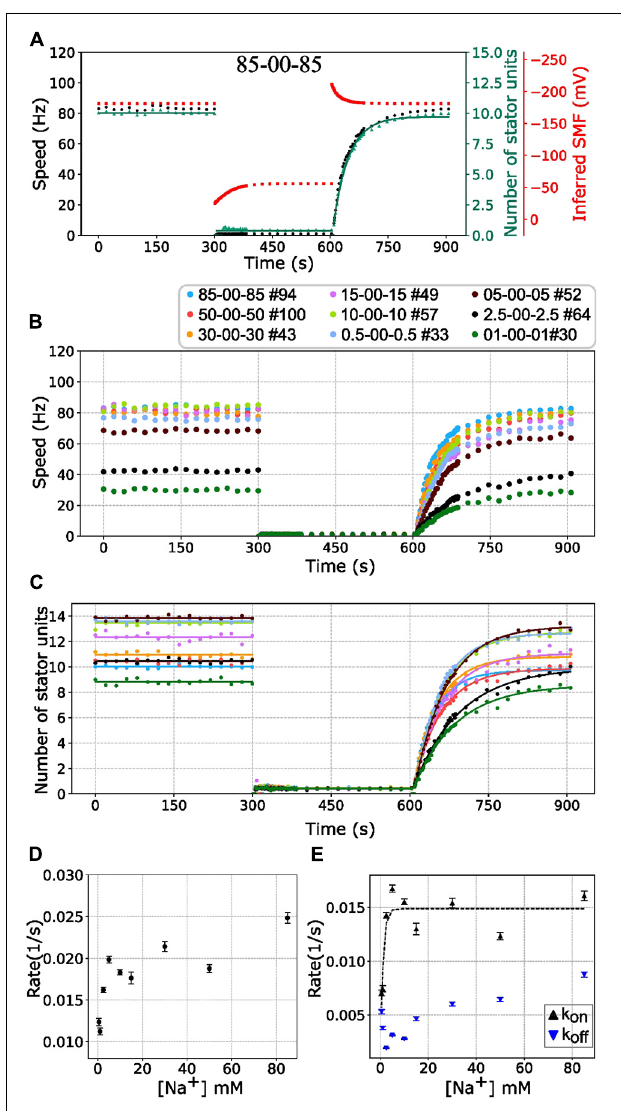
FIGURE 4 | BFM speed and stator number kinetics to zero [Na + ] ex . (A) Perfusion experiment of 85-00-85 mM sequence. The black dots show the average BFM speed. The red dots represent the inferred SMF. The green dots and line represent the number of stator units and fitting result to the simple Hill–Langmuir absorption model (B) BFM speed data collection of perfusion experiments with different [Na + ] ex . The legend indicates the perfusion [Na + ] ex sequence and the number of BFM speed data collected. (C) The dots and lines show the number of stator units inferred from the speed results in B and the fitting results, respectively. (D) The recovery rate constants in the third stages (zero to high [Na + ] ex ) in C versus [Na + ] ex . (E) The K on and K off according to the sodium concentration derived from panels (C,D) . The black tendency line for the K on is obtained by fitting a simple exponential curve. The error bar in panels (D,E) represents the standard deviation of the fitting parameter.